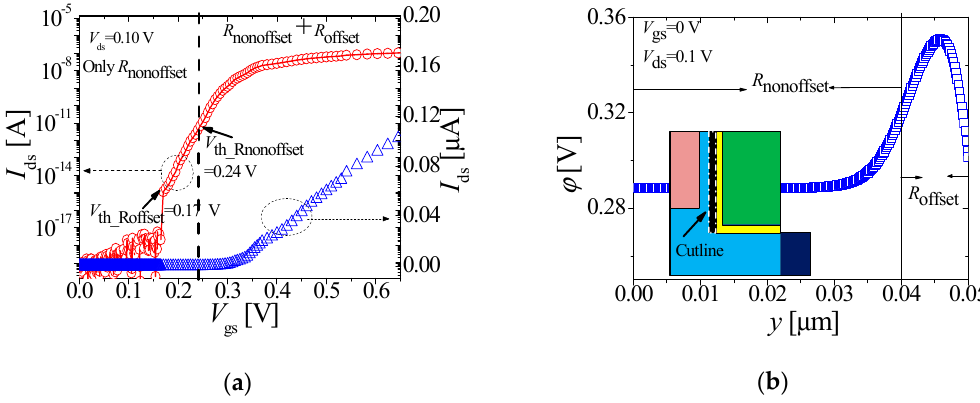
Figure 2. ( a ) I ds - V gs transfer characteristics of the LTFET. V th_Rnonoffset = 0.24 V and V th_Roffset = 0.17 V. ( b ) Potential along the cutline shown in the inset at V gs = 0 V. Potential is higher in R offset .